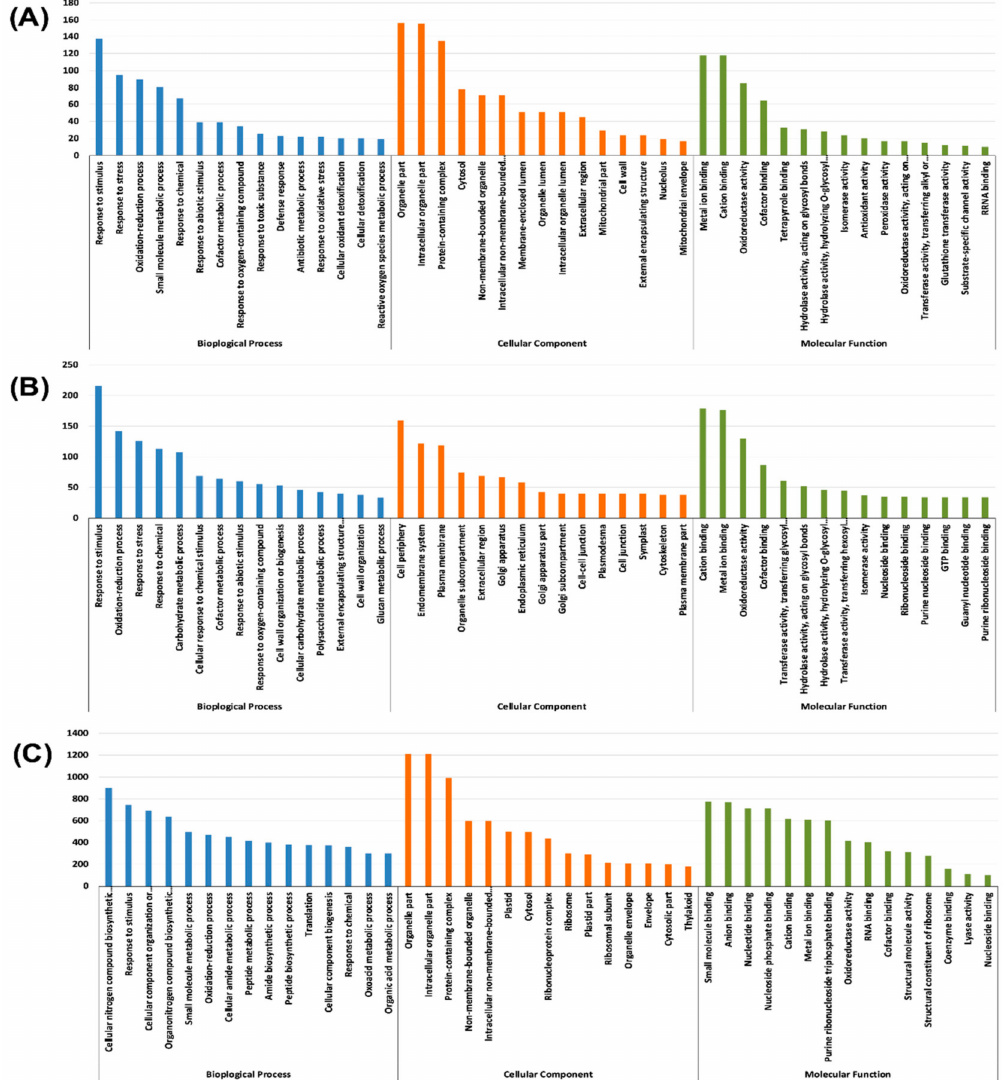
Figure 4. Functional gene ontology annotations of di ff erentially expressed genes (DEGs) under Fe and Zn stresses in the root: ( A ) –Zn; ( B ) –Fe; and ( C ) –Fe–Zn. For graphical representation, we have the top 15 significant terms under each category viz ., biological process (blue), cellular component (orange), and molecular function (green). The complete list of terms along with significance of false discovery rate (FDR) < 0.05 are mentioned in Table